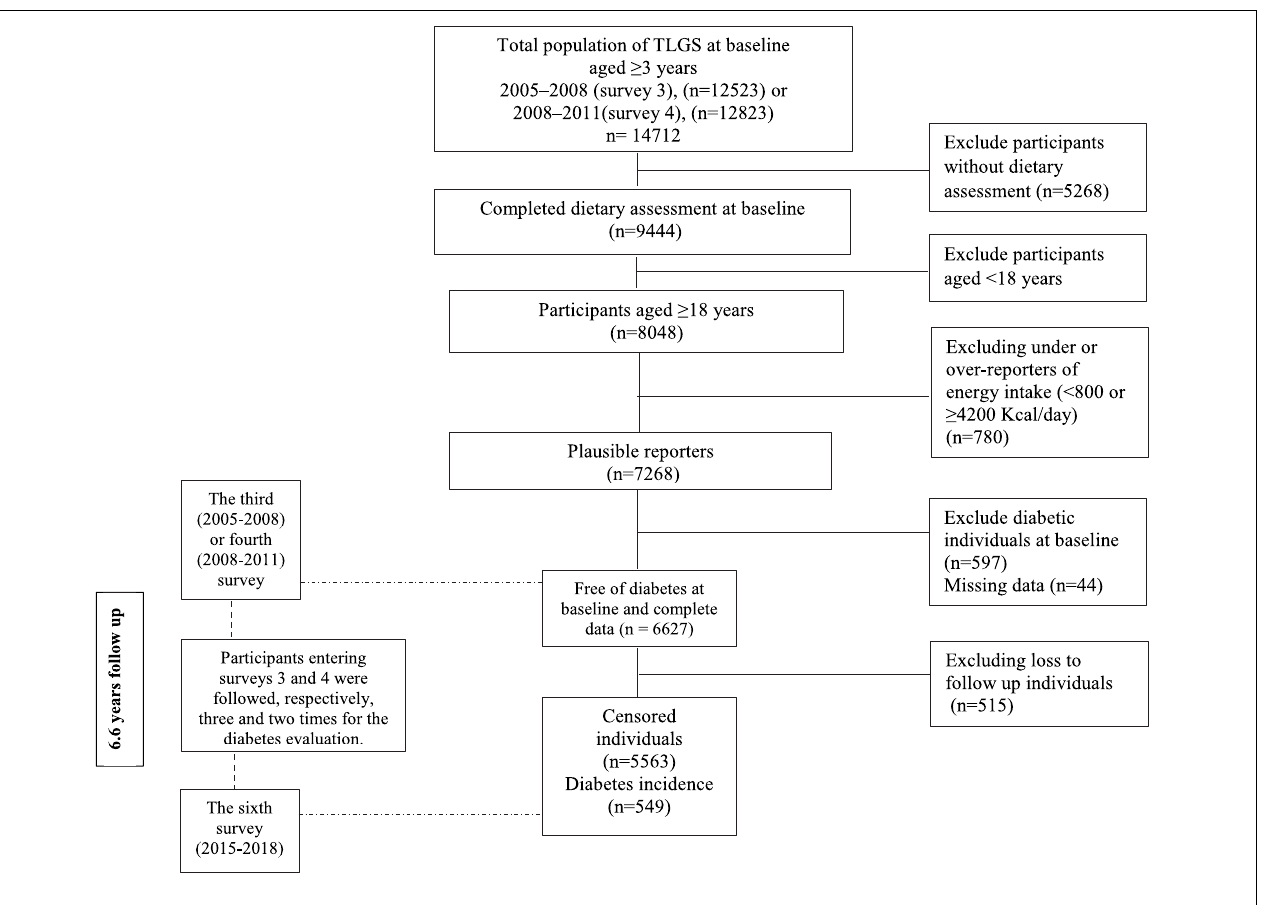
FIGURE 1 | Outline of study participants’